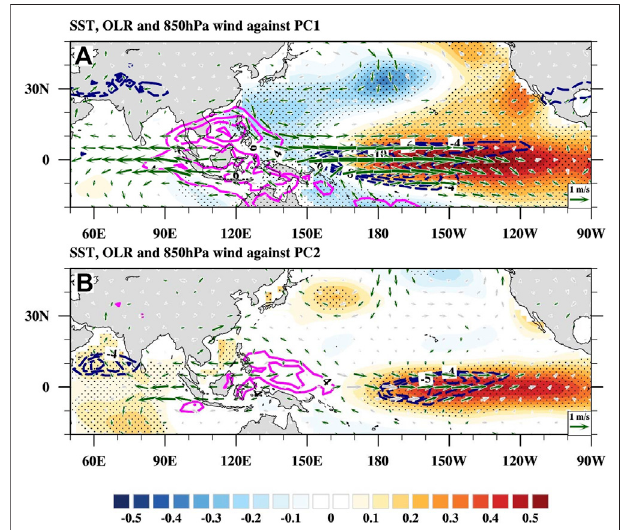
FIGURE 5 | Regressed SST (shading, K), OLR (contours, W m − 2 ), and 850 hPa wind (vectors, m s − 1 ) anomalies against the (A) PC1 and (B) PC2 during 1965 – 2018. Dots (green vectors) denote the anomalous SST (winds) that are signi fi cant at 90% con fi dence level.